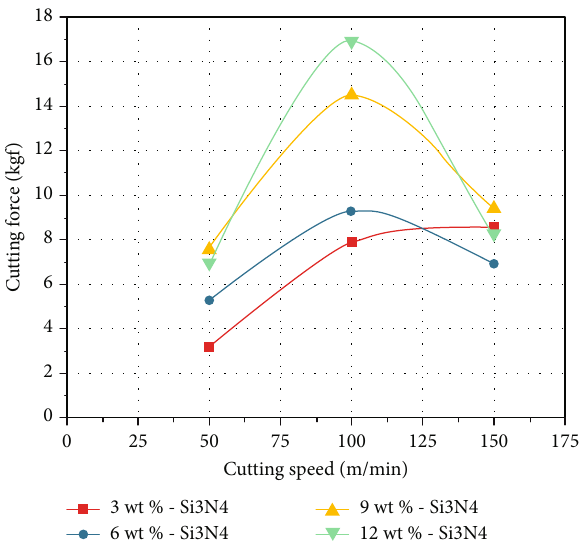
Figure 11: Cutting speed vs. cutting force (depth of cut 1.2mm).